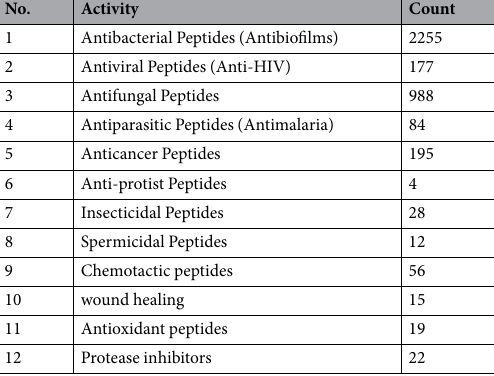
Table 1. Number of sequences for different